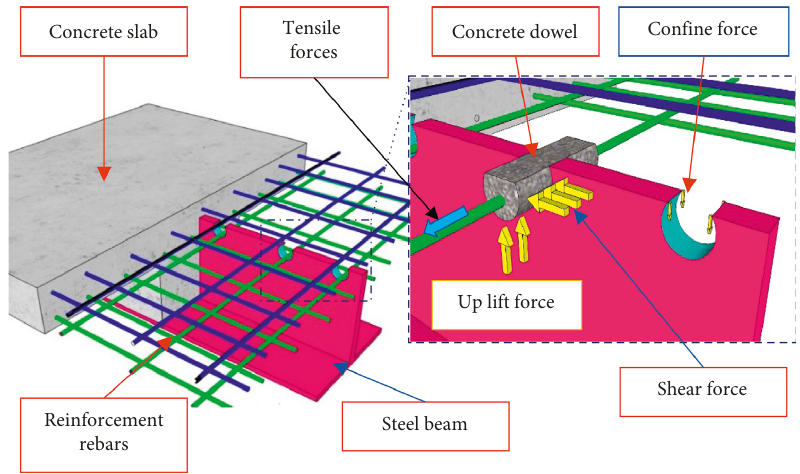
Figure 16: Application of concrete dowels for slim floor